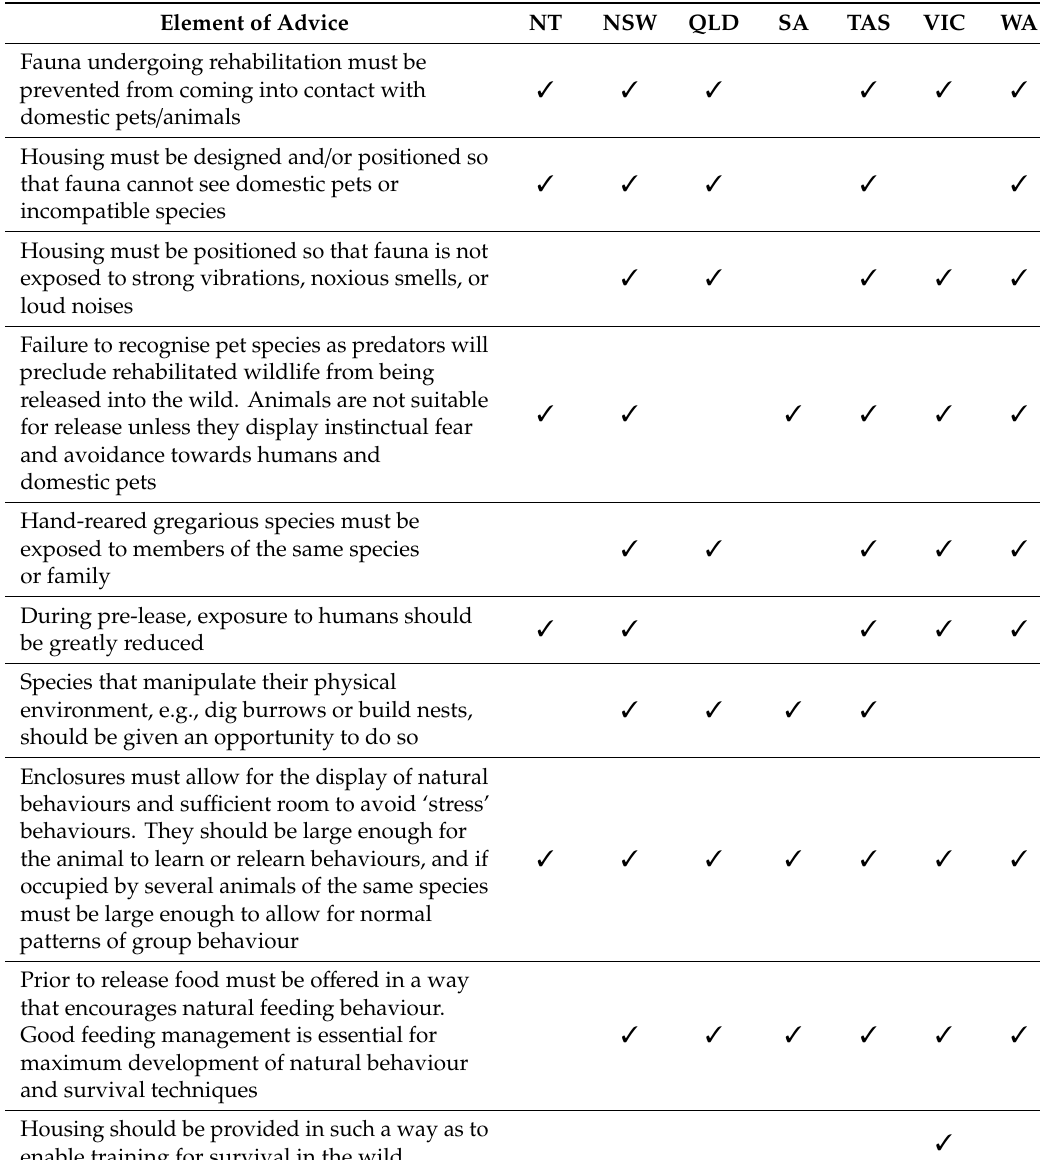
Table 6. List of advice given to Australian wildlife carers for pre-release behavior conditions. When not identical, similarities in advice have been placed into a single